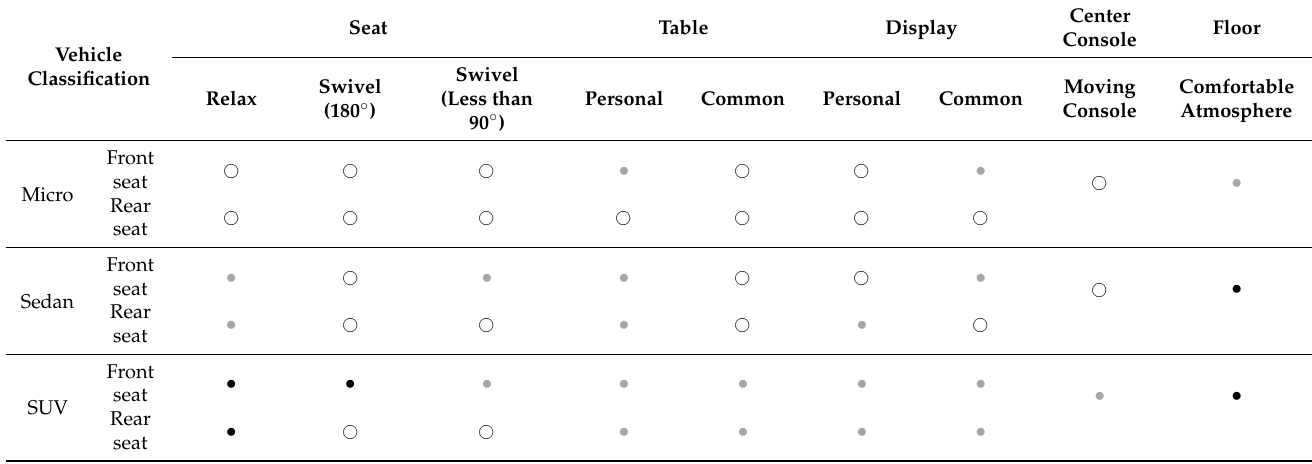
Table 5. Spatial components by vehicle classification ( • : many cases of a concept car, • : several cases of a concept car, few cases of concept car).